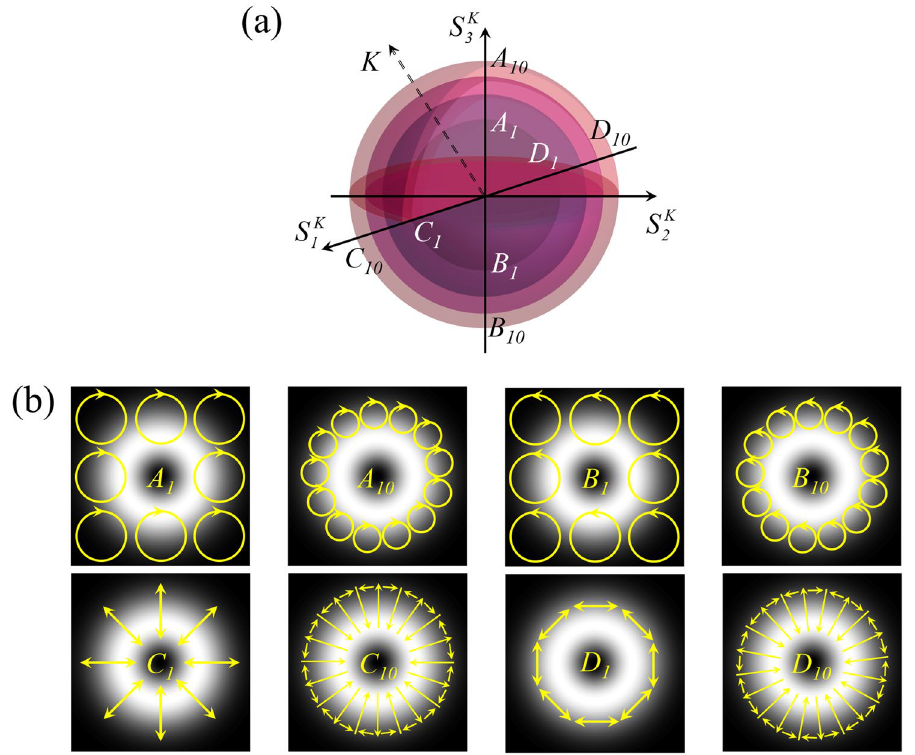
Figure 7. ( a ) Representation of vector optical fields on multi-layered higher-order Poincaré spheres. Each layer is corresponding to a certain value of K . ( b ) Simulation of local polarization vector states at various positions on the higher-order Poincaré